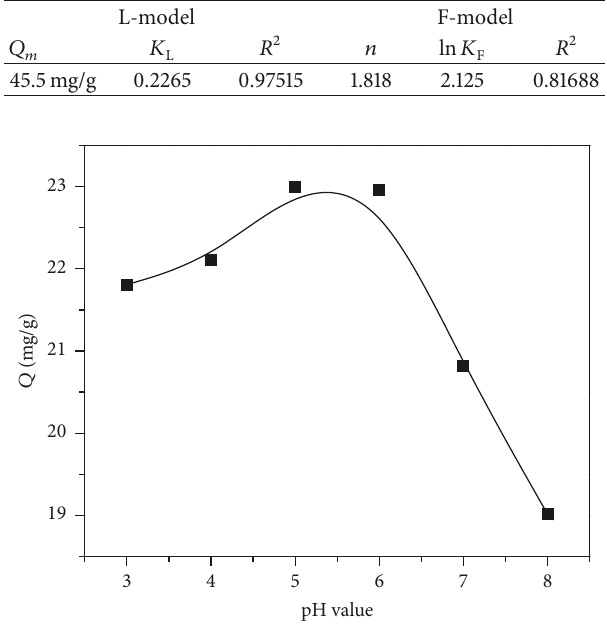
Figure 4: Influence of pH on the adsorption capacity (conditions: adsorption time, 24 h; initial concentration of solution, 24 mg/L; amount of adsorbent, 1.0 g/L).